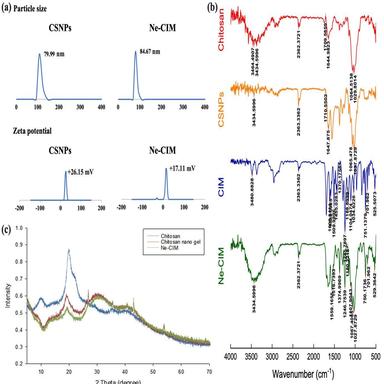
Characterization of chitosan cinnamic acid nanogel (a) Particle size and zeta potential of CSNPs and Ne-CIM (b) FTIR spectra of chitosan, CSNPs, CIM and Ne-CIM, and (c) X-Ray diffraction of chitosan, CSNPs and Ne-CIM.